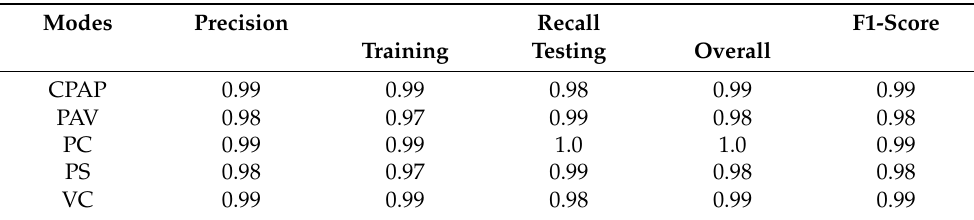
Table 7. Model evaluation report for Random-Forest algorithm.